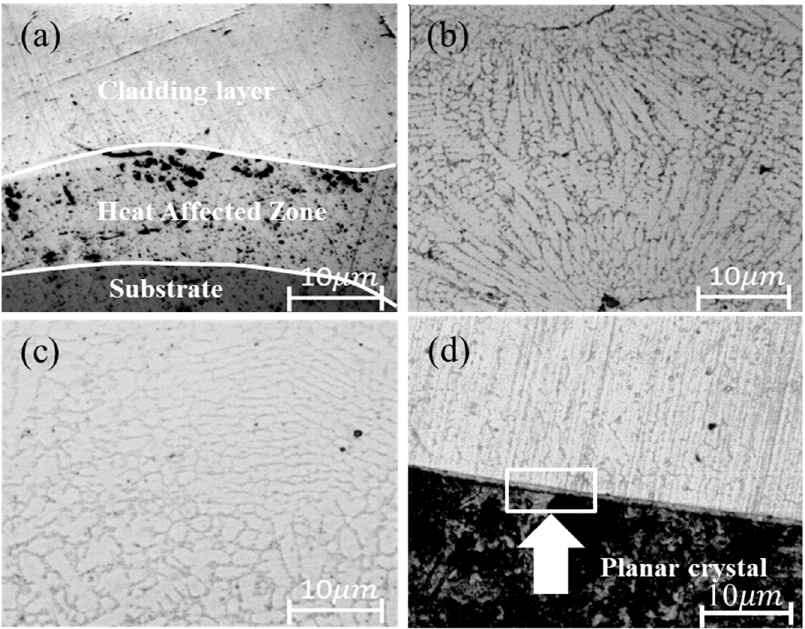
Figure 4. OM images of Sn 0 coating: ( a ) longitudinal section of the coating; ( b ) bottom area of the coating; ( c ) topside area of the coating; ( d ) bonding area between the coating and the substrate.